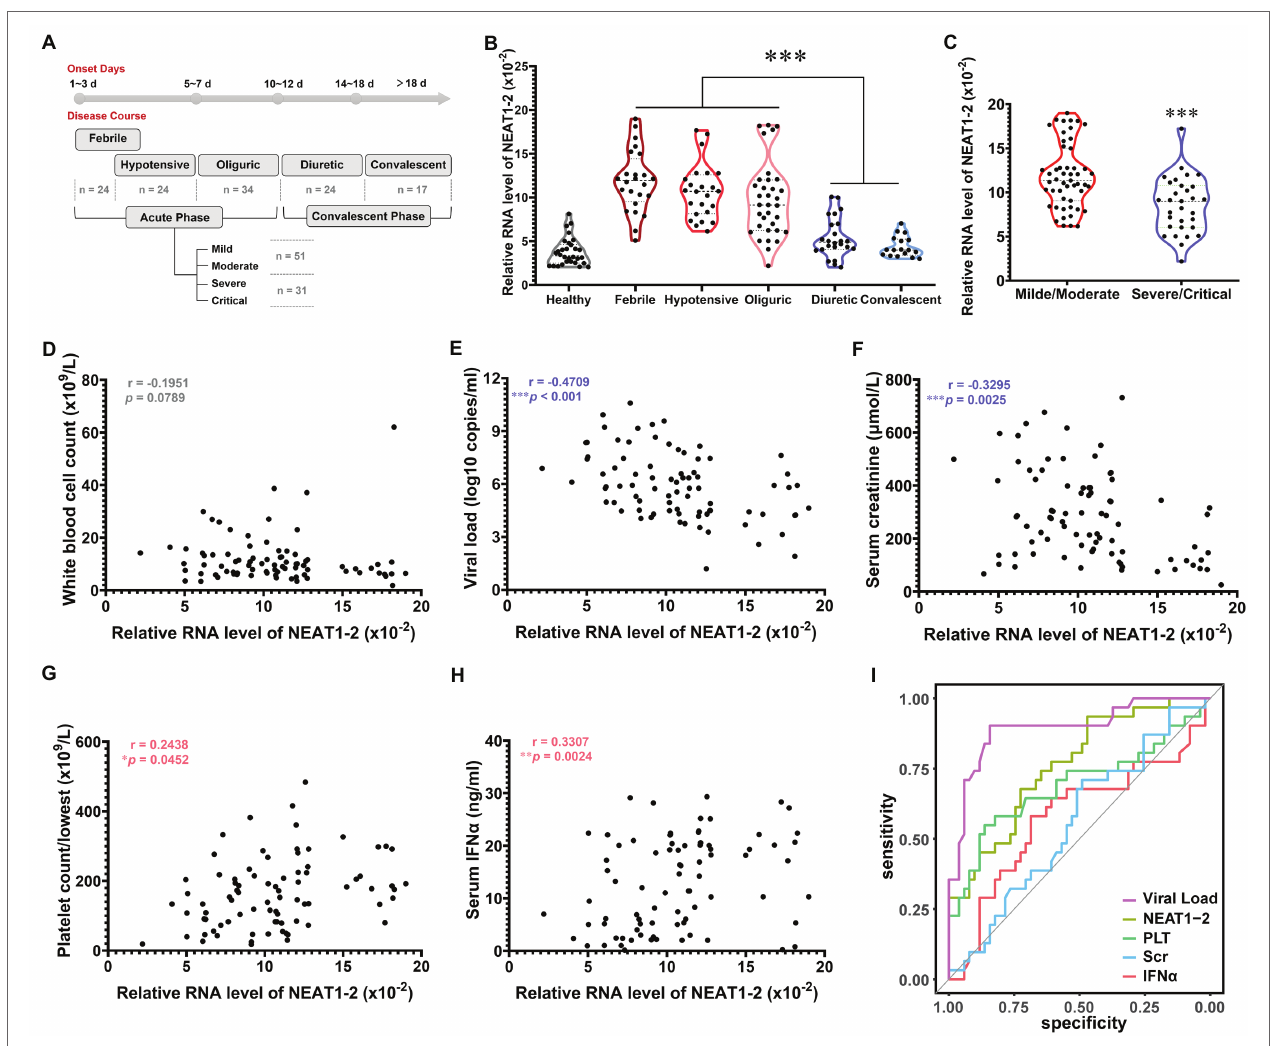
FIGURE 6 | Inverse Relationship of NEAT1-2 Expression with HFRS Disease Severity. (A) Classification of clinical stages and disease severity for enrolled HFRS patients. Healthy control group, n = 30; febrile group (not combined with hypotensive shock), n = 24; hypotensive group (with or without fever), n = 24; oliguric group, n = 34; diuretic group, n = 24; convalescent group, n = 17. For the acute phase, mild/moderate group, n = 51; severe/critical group, n = 31. (B) qRT-PCR analysis of NEAT1-2 expression levels in monocytes from HFRS patients at different disease stages. (C) qRT-PCR analysis of NEAT1-2 expression levels in monocytes from HFRS patients at the acute phase but with different disease severities. (D-H) The correlation of NEAT1-2 expression level in monocytes from HFRS patients at the acute phase with white blood cell count (WBC) (D) , viral load (E) , serum creatinine concentration (Scr) (F), the lowest value of platelet count (PLT) (G) or serum IFN α concentration (H) . (I) Receiver operating characteristic curve (ROC) and area under the curve (AUC) analyses of the prognostic values of various clinical parameters for HFRS disease severity. Data are shown as the median, quartile, and standard deviation. Each point represents a single sample. Analysis was performed using the one-way ANOVA (B) , unpaired Student’s t test (C) , or Spearman’s rank correlation test (D-H) . * p < 0.05, ** p < 0.01, and *** p <